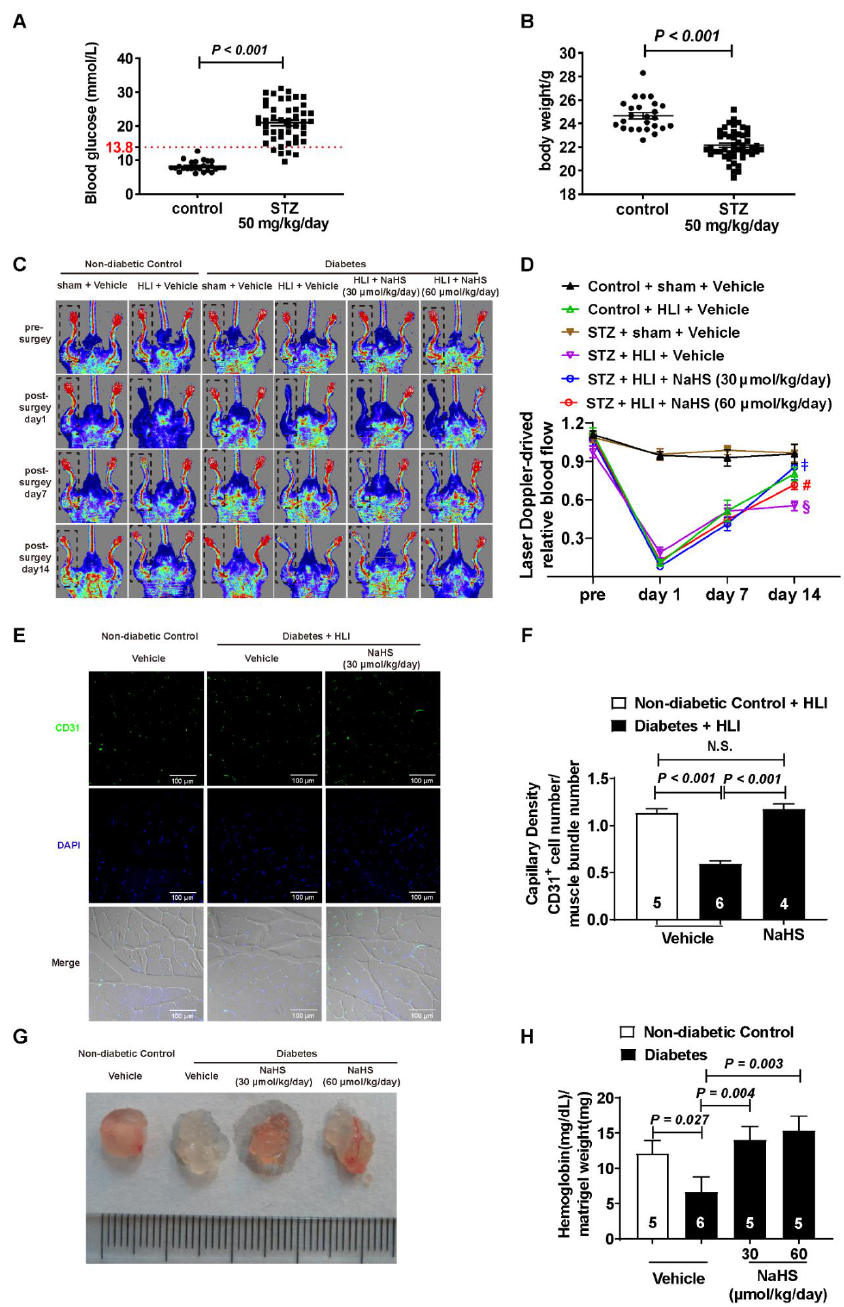
Figure 1. Exogenous H 2 S promoted angiogenesis in vivo. ( A ) Blood glucose fasting in mice for 4 h before and after STZ (50 mg/kg/day) treatment every day for five days. ( B ) Body weight of the mice before and after STZ (50 mg/kg/day) treatment every day for five days. ( C , D ) Representative blood